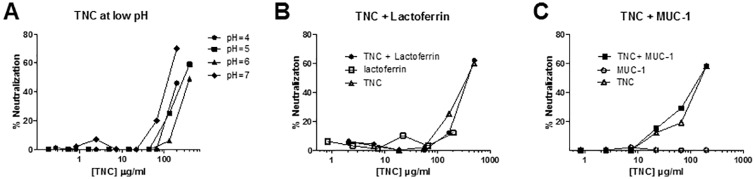
Antiviral activity of TNC in low pH conditions and in the presence of other mucosal innate HIV-1 inhibitors.(A) Neutralization potency of purified TNC was measured after low pH treatment to simulate the low pH of the vaginal compartment against HIV-1 C.DU156. (B) Neutralization potency of purified TNC starting at 200 μg/ml, purified lactoferrin starting at 500 μg/ml, and TNC plus lactoferrin (reported in TNC concentration) was determined against HIV-1 C.DU156 in TZM-bl cells. (C) In a separate assay, purified TNC starting at 200 μg/ml, recombinant MUC-1 starting at 200 μg/ml, and TNC plus MUC-1 (reported in TNC concentration) was determined against HIV-1 C.DU156. Neither the addition of purified lactoferrin or MUC-1 to TNC had additive or inhibitory effects on TNC’s HIV-1 neutralizing potency.